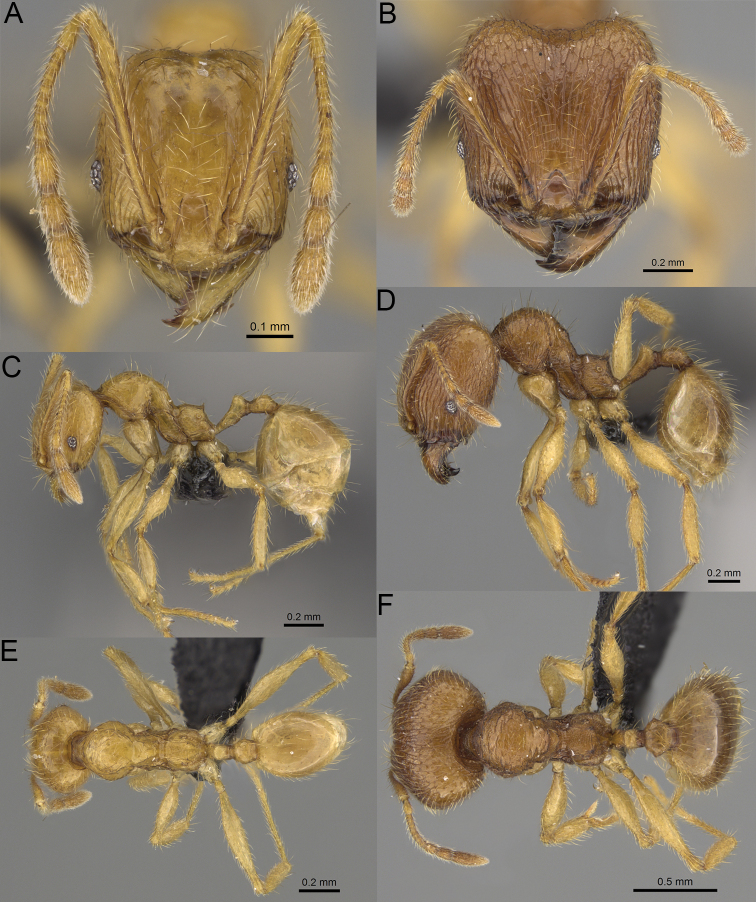
Pheidole
haboka sp. nov., full-face view (A), profile (C), and dorsal view (E) of paratype minor worker (CASENT0491601) and full-face view (B), profile (D), and dorsal view (F) of holotype major worker (CASENT0491605).